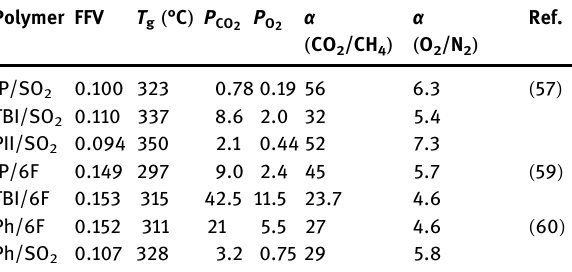
Table 1: Fractional free volume ( FFV ) , glass transition temperature ( T ) , and gas permeability ( P ) ( in Barrers ) and permselectivity ( α ) g values of the polyisophthalamides containing di ff erent bulky pen - dant groups at 35°C Polymer FFV